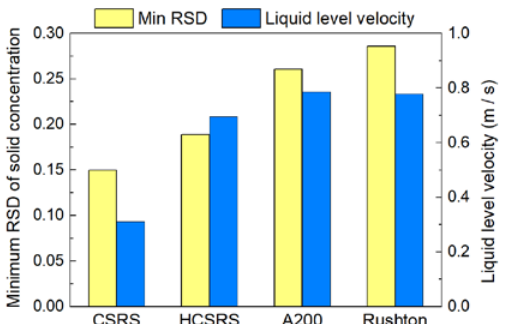
Figure 16. The minimum relative standard deviation of particle concentration and the corresponding average liquid level velocity obtained by the four agitators.